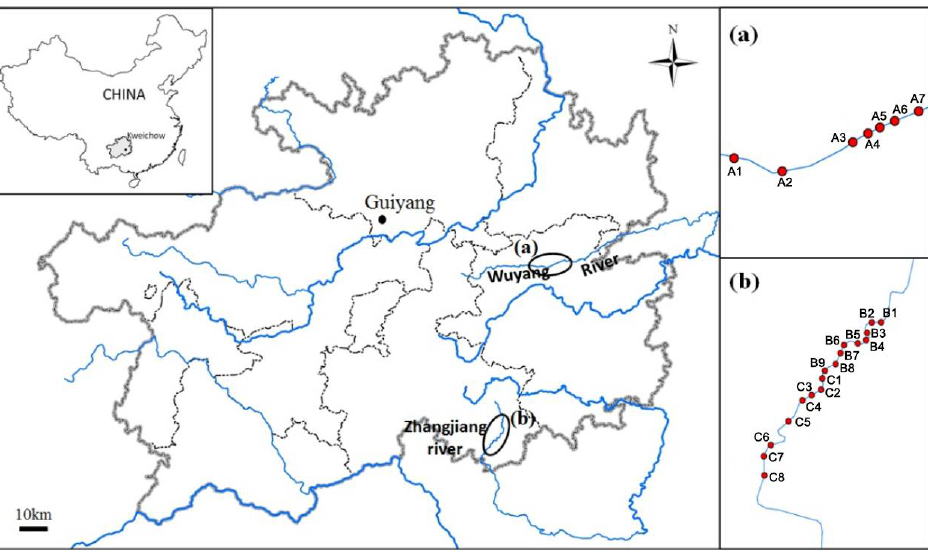
Figure 1. Sampling sites (red circles) along the Wuyang ( a ) and Zhangjiang ( b ) rivers in southwestern China. Sites A1 to A7 represent a developed inland waterway in the Wuyang river; sites B1 to B9 represent a stretch of inland waterway under construction along the Zhangjiang river; and sites C1 to C8 represent an undisturbed stretch of the Zhangjiang river.